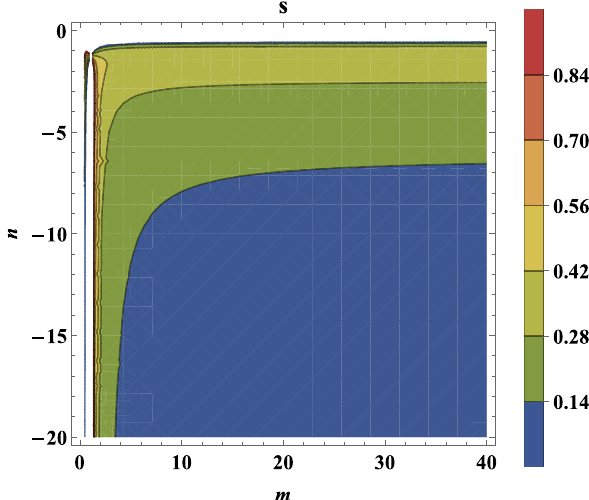
Fig. 3 The figure displays the value of the effective equation of state as a function of the two parameters n and m for the B critical point